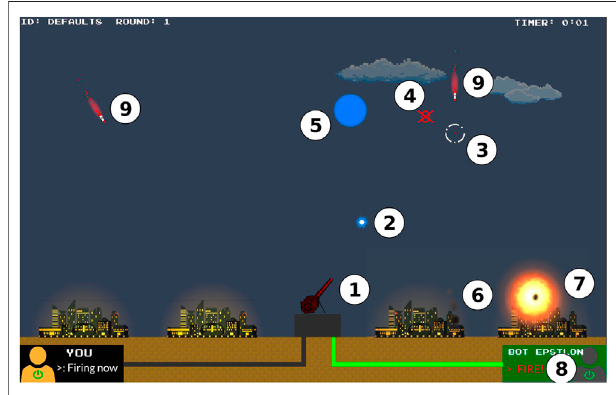
FIGURE 1 | Annotated screen-capture of the missile command